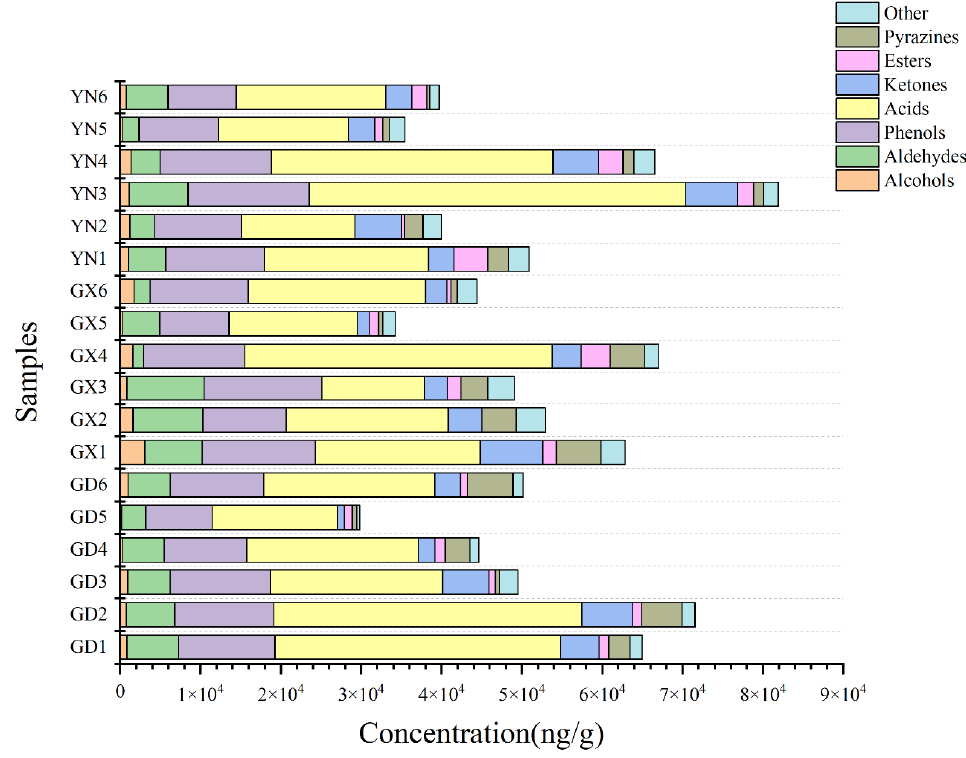
Figure 1. The average content of different kinds of compounds in three regions. Table 1. Volatile aroma components of brown sugars from different producing areas.